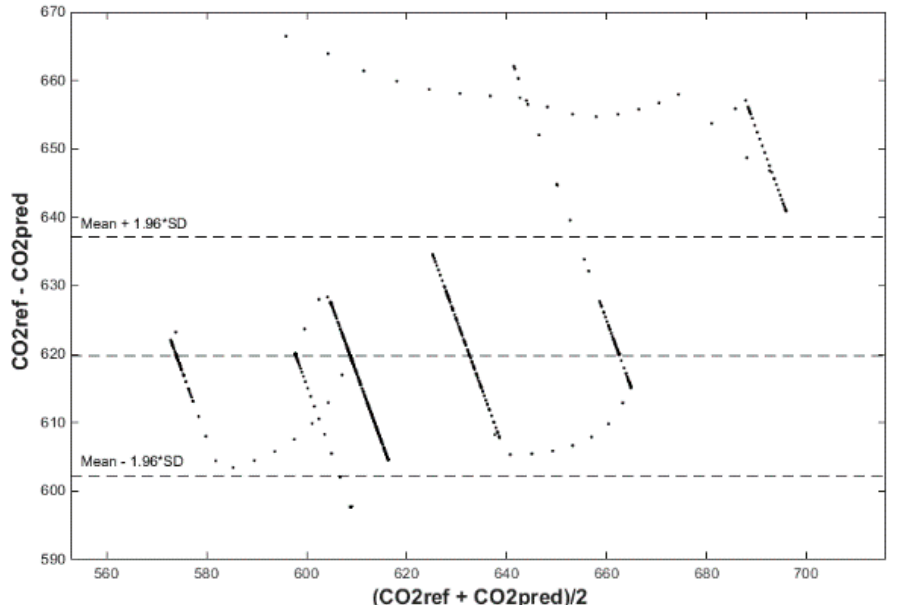
Figure 22. Bland–Altman plot for the reference and predicted CO 2 waveforms (SRLMS AF) from 28 June 2018 in R204 with an ANN with 40 neurons and SCG method trained with data from 25 June 2018 in R203.